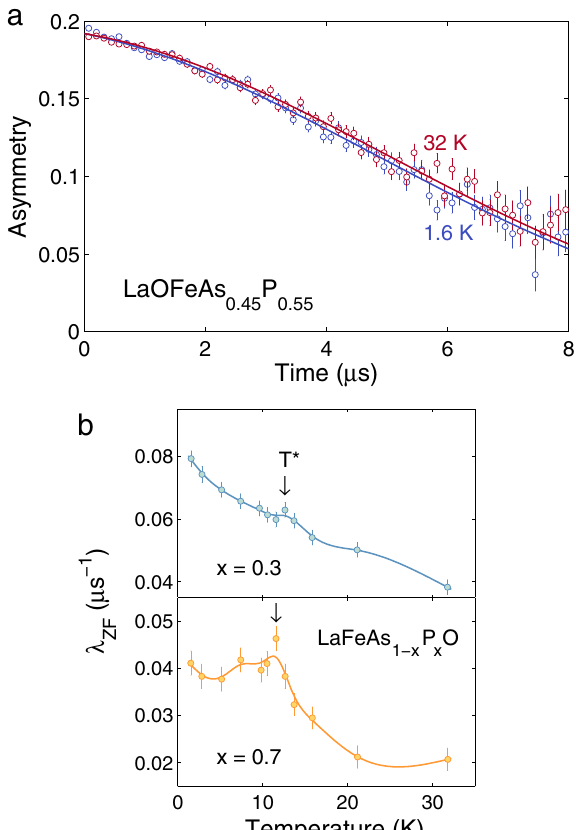
Fig. 2 Zero- fi eld μ SR relaxation. a Representative LaFeAs 1 − x P x O zero- fi eld μ SR spectra above and below T c , for x = 0.55, fi tted by means of Eq. (1). b For many samples the relaxation is rather inconspicuous, yet it invariably shows a tiny peak close to T * (arrows), corresponding to a maximum in electronic spin fl uctua- tions (see text). Lines are guides to the